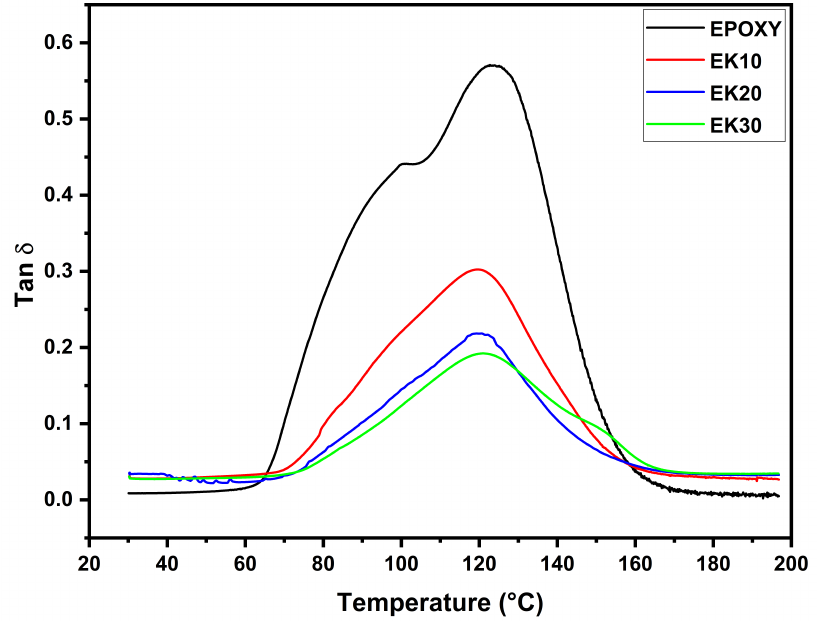
Figure 5. Damping factor (Tan δ ) curves for epoxy composites incorporated with different amounts of kenaf